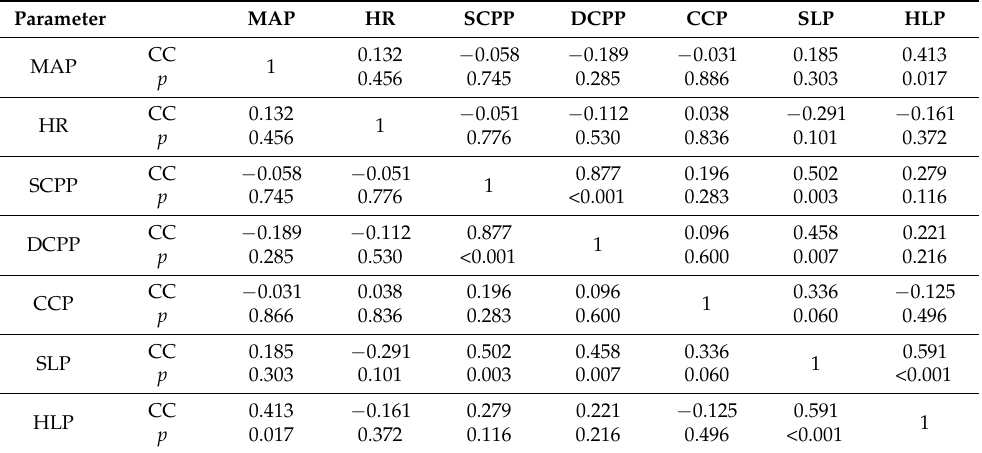
Table 5. Correlation analysis of changes in arterial pressure, heart rate, and ocular perfusion values due to dynamic